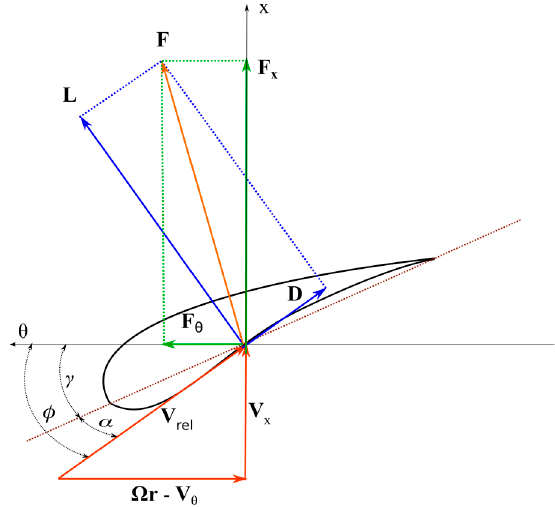
Figure 1. Cross section of a blade element with forces acting during operation.